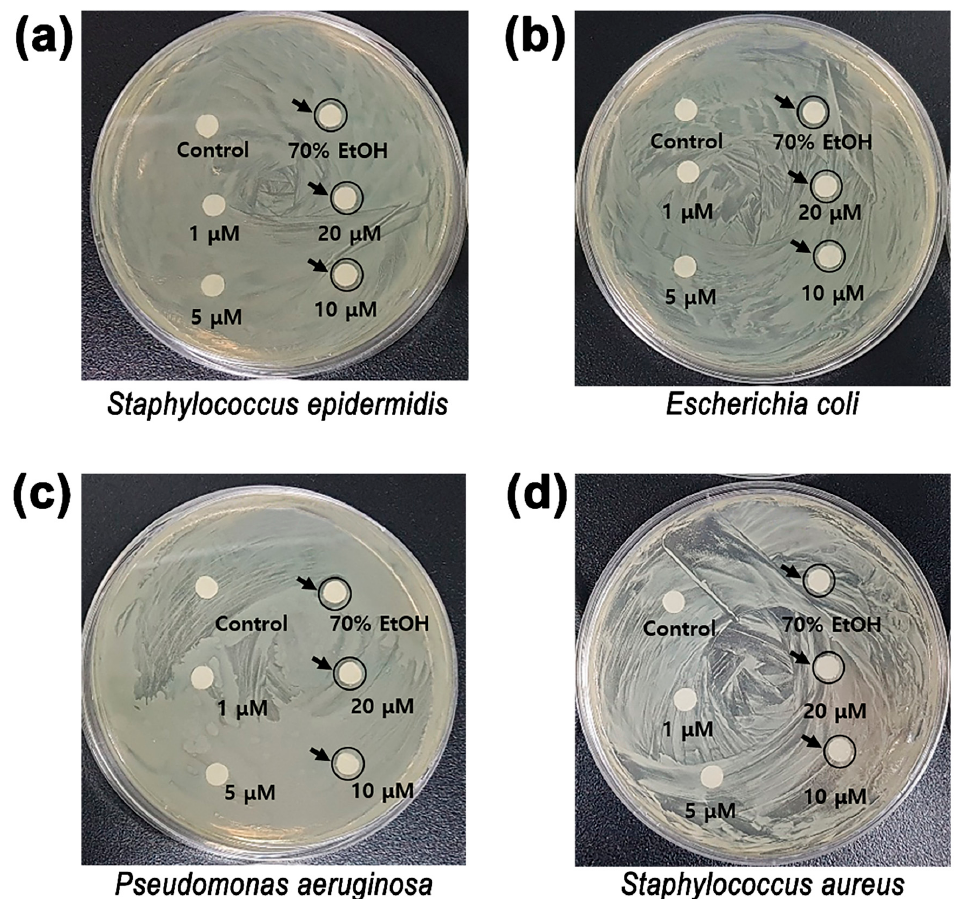
Figure 6. Antibacterial activity determined by paper disc method. ( a ) Staphylococcus epidermidis , ( b ) Escherichia coli , ( c ) Pseudomonas aeruginosa , and ( d ) Staphylococcus aureus . Hispidin concentrations were 1 µM, 5 µM, 10 µM, and 20 µM. The positive control was obtained using 70% EtOH and the negative control was obtained using sterilized DIW.